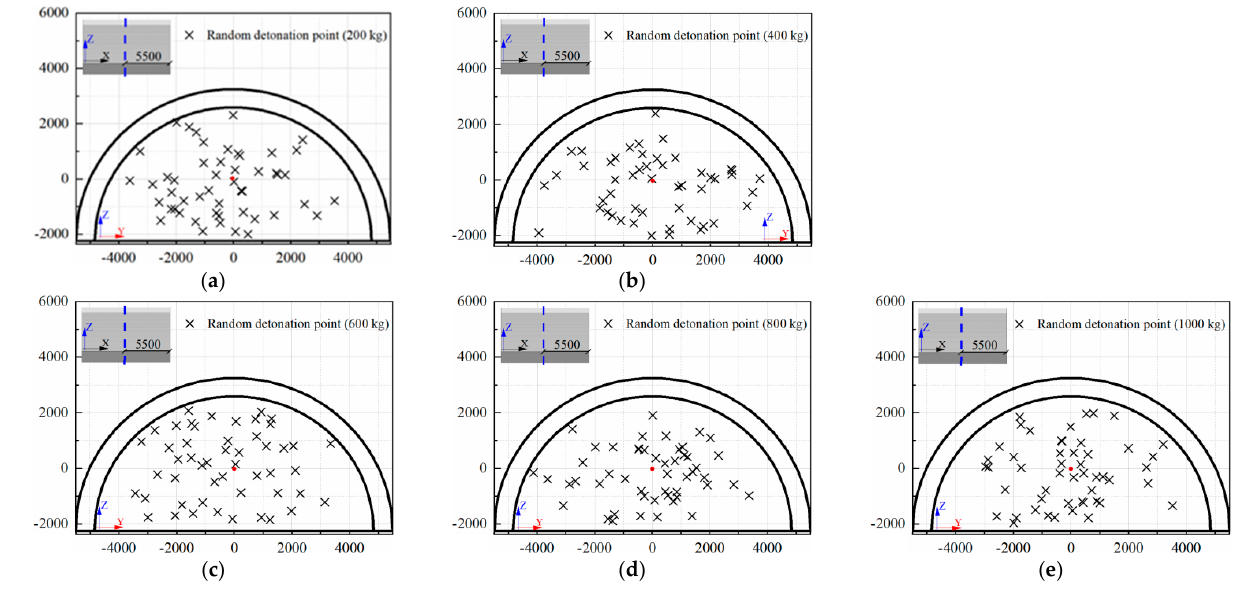
Figure 12. Coordinates of random detonation points (unit: mm): ( a ) W = 200 kg, ( b ) W = 400 kg, ( c ) W = 600 kg, ( d ) W = 800 kg, ( e ) W = 1000 kg.